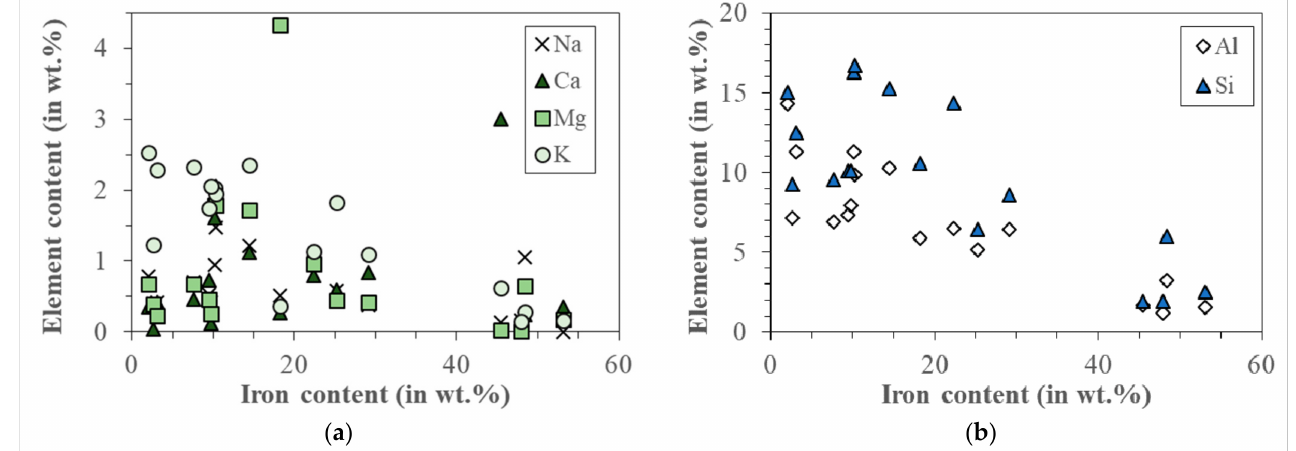
Figure 8. ( a ) Correlations between potassium, sodium, calcium, magnesium, content (in wt.%) and the iron content in magnetic particles; ( b ) dependence of silicon and aluminum content in individual magnetic particles as a function of iron.